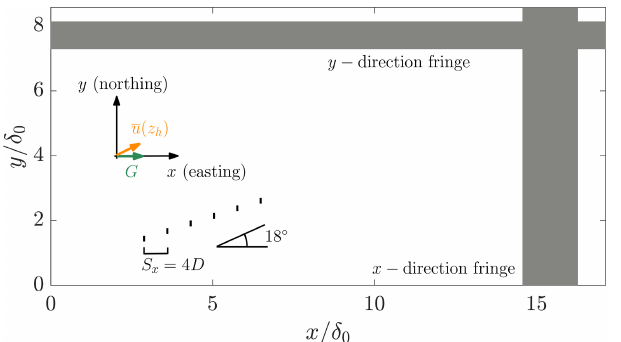
Figure 3. Conventionally neutral six wind turbine finite wind farm simulation setup. The geostrophic wind direction is west to east, and the x axis is aligned with the geostrophic wind direction. The mean wind direction at hub height is tan − 1 ( v/u ) ≈ 16 ◦ , but it is not known a priori in the simulation and varies as a function of time. The wind turbine array is offset from alignment in the x direction by 18 ◦ . The initial boundary layer height δ 0 is 700m and does not change significantly during runtime (see Fig. 4). Fringe functions are applied in the x and y directions to establish a finite wind farm